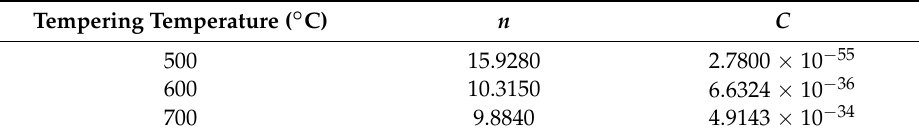
Table 10. Material constants C and n at tempering temperatures 500 ◦ C, 600 ◦ C, and 700 ◦